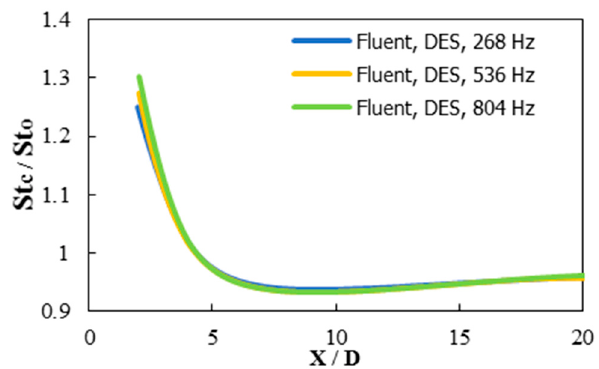
Figure 26. ( a ) The instantaneous temperature contour for the central cross section using the FLUENT, LES, Smagorinsky–Lilly model for M = 0.5, 1072 Hz ( b ). [28] The instantaneous temperature contour